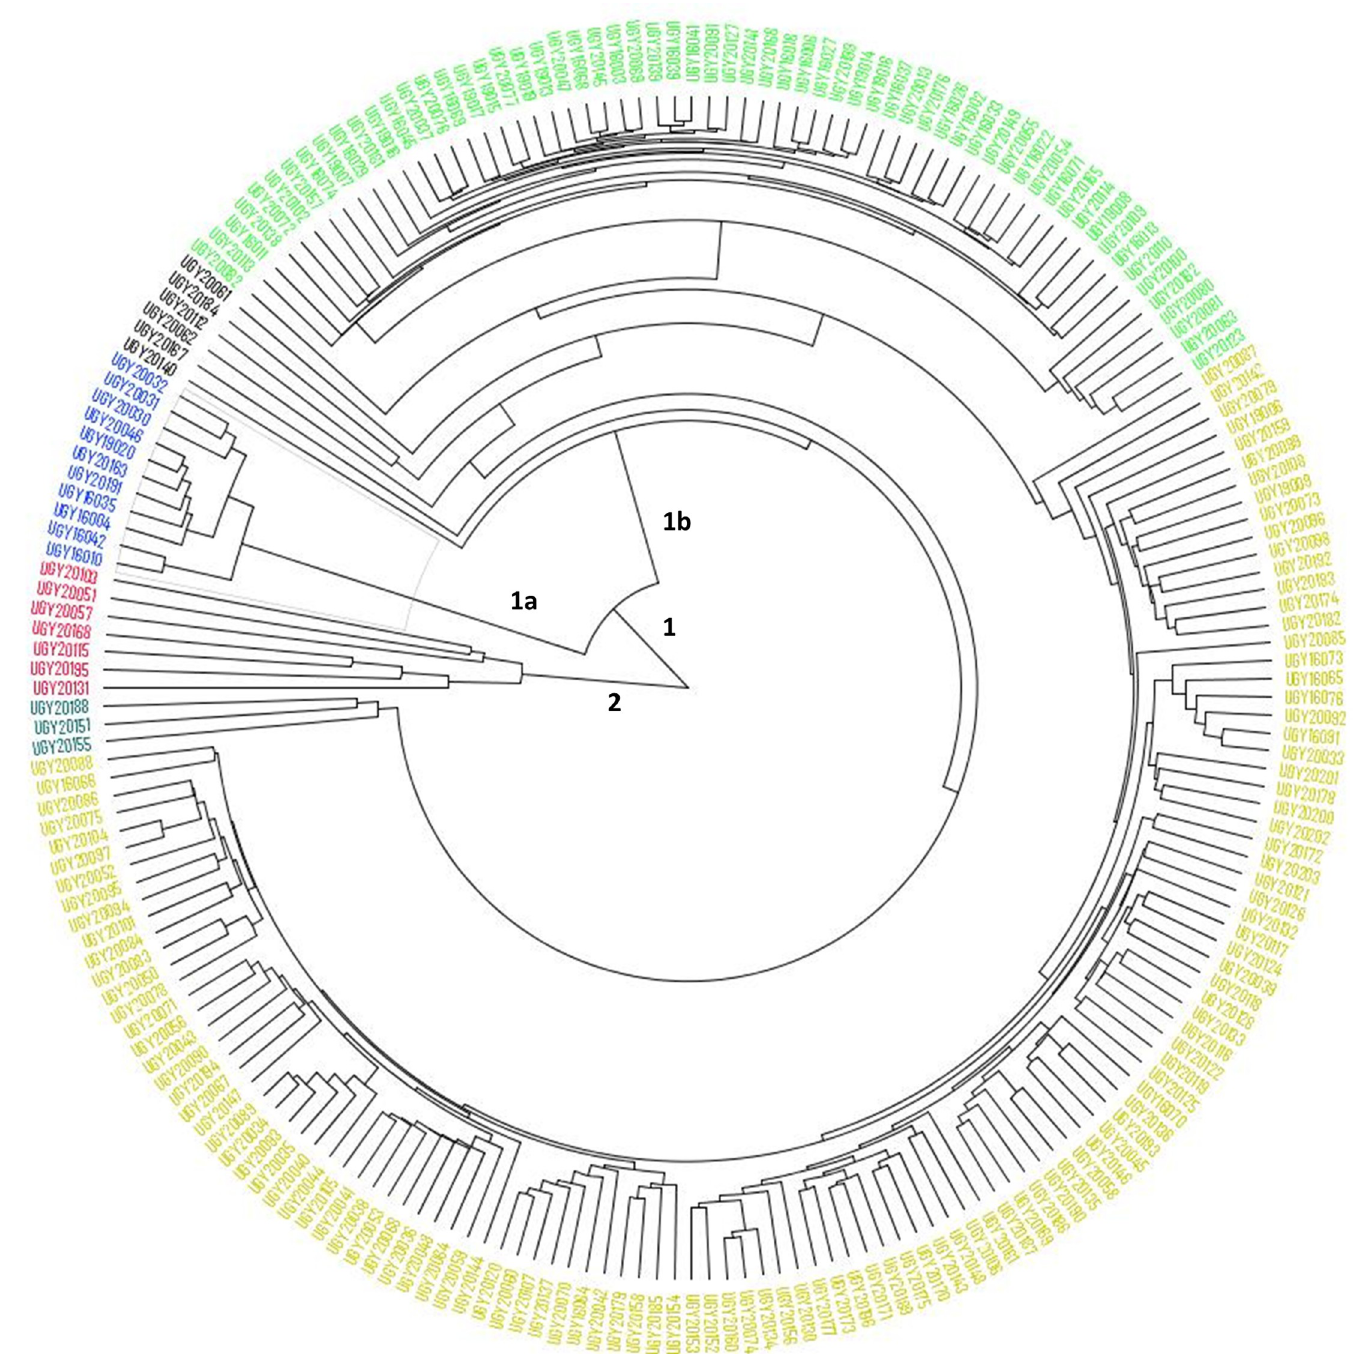
Fig 4. Hierarchical clustering of 207 yam genotypes based on 4,957 SNPs. https://doi.org/10.1371/journal.pone.0277537.g004 sourced from West Africa (Ghana and Nigeria) with only 10 genotypes (7.3%) sourced from Uganda. However, the cluster groupings and probabilities of cluster membership allocations of genotypes in K = 3 were maintained and equally represented in K = 4 (Fig 6D). The PIC proportion among the clusters ranged from 0.16 to 0.31, with a mean of 0.24 (Table 3). Cluster